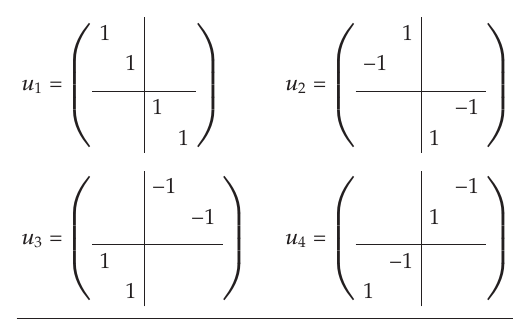
Table 1: The boson “up” linkage matrices for the left 4-4 Valise Adinkra shown in Figure 1. The up matrices for the right Adinkra in that figure are obtained from these by changing the sign of u 3